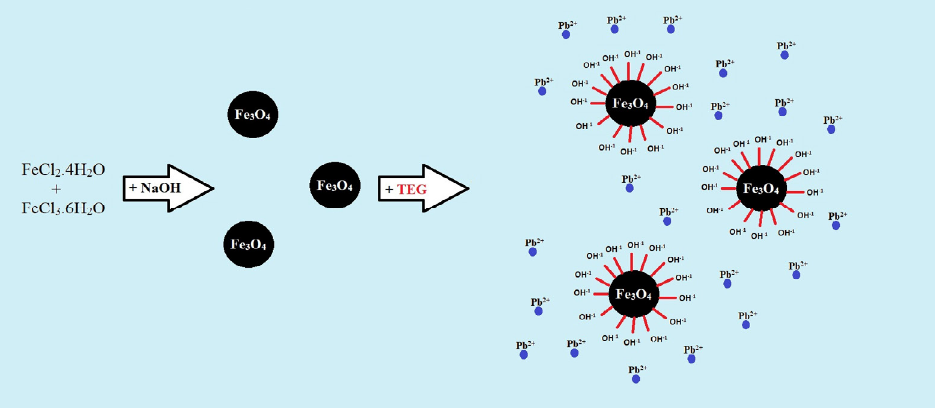
O nanoparticles. 3 4